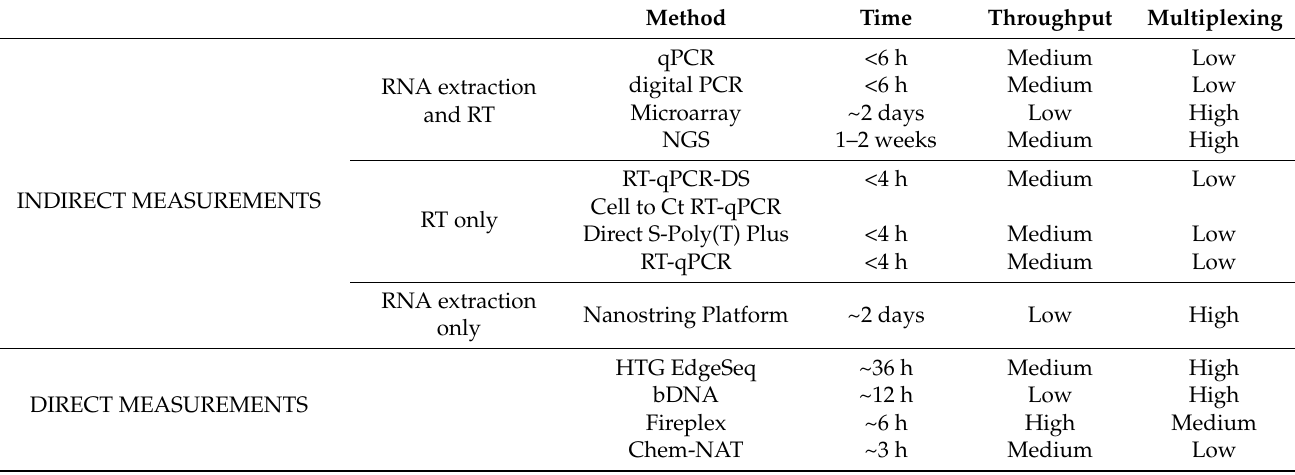
Table 2. Summary of the different time, throughput and multiplexing of the different methods described in this